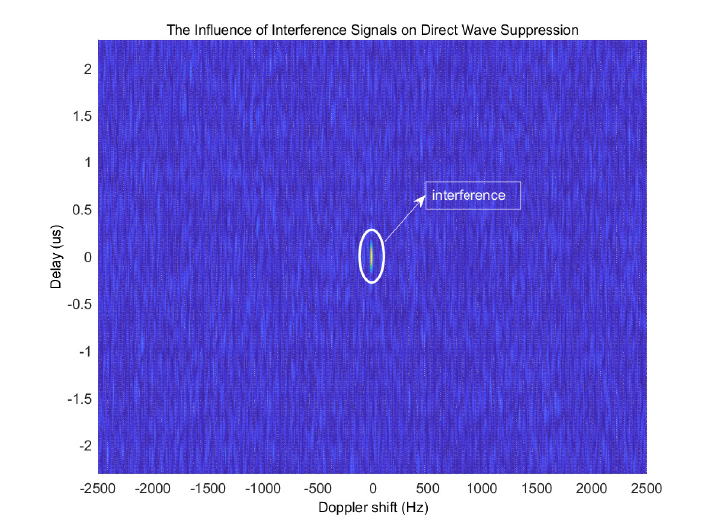
Figure 6. The influence of reference channel SIR on DPI and MPI suppression with SNR = 10 dB.